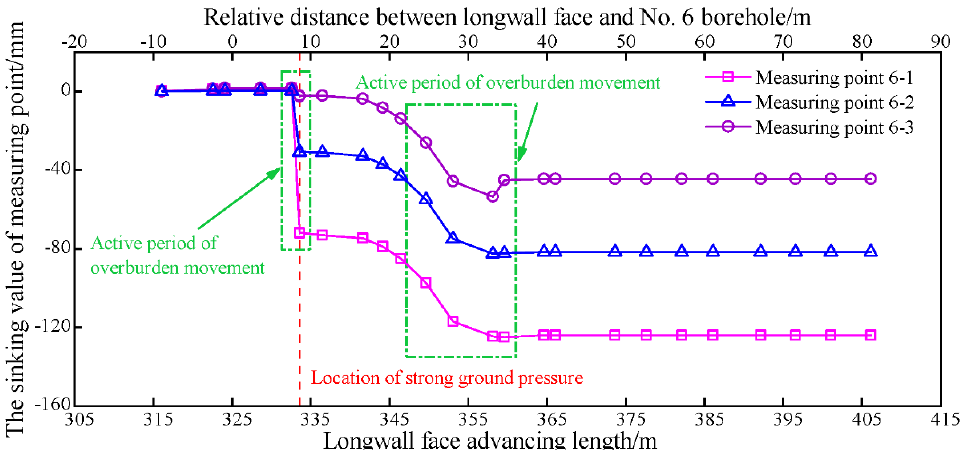
Figure 4. Relationship between each measuring point sinking amount and the distance between the 6107 longwall face and hole No. 6.